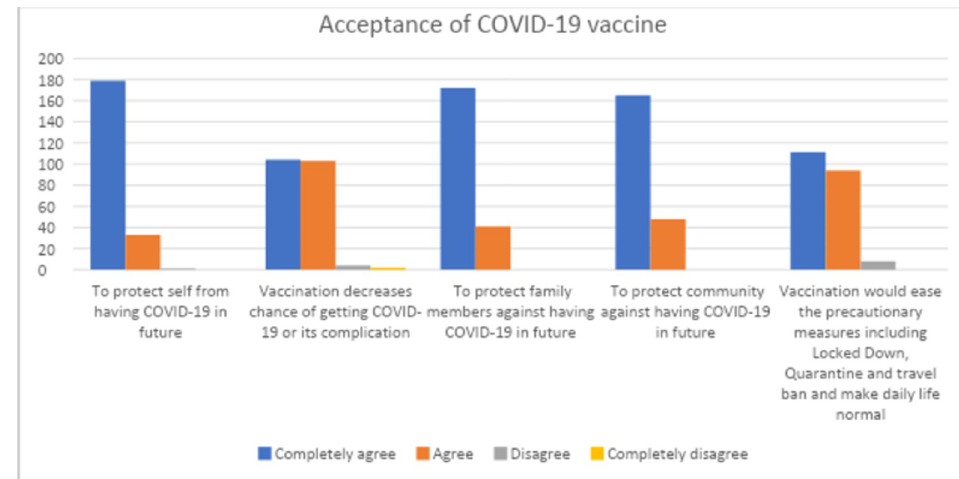
Fig 1. Acceptance of COVID-19 vaccine among Nepalese